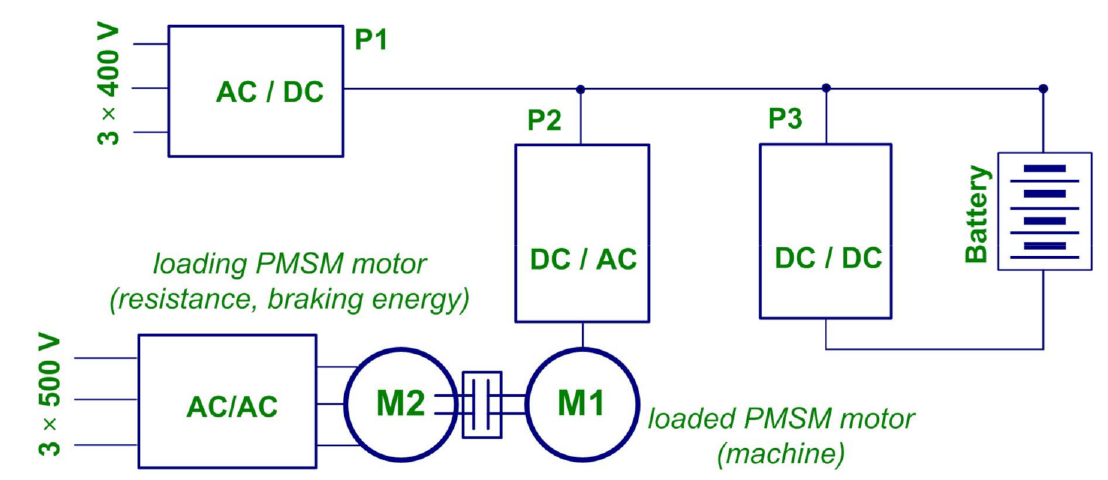
Figure 10. Measuring system for validation tests of the electric drive in the riding and operation mode.